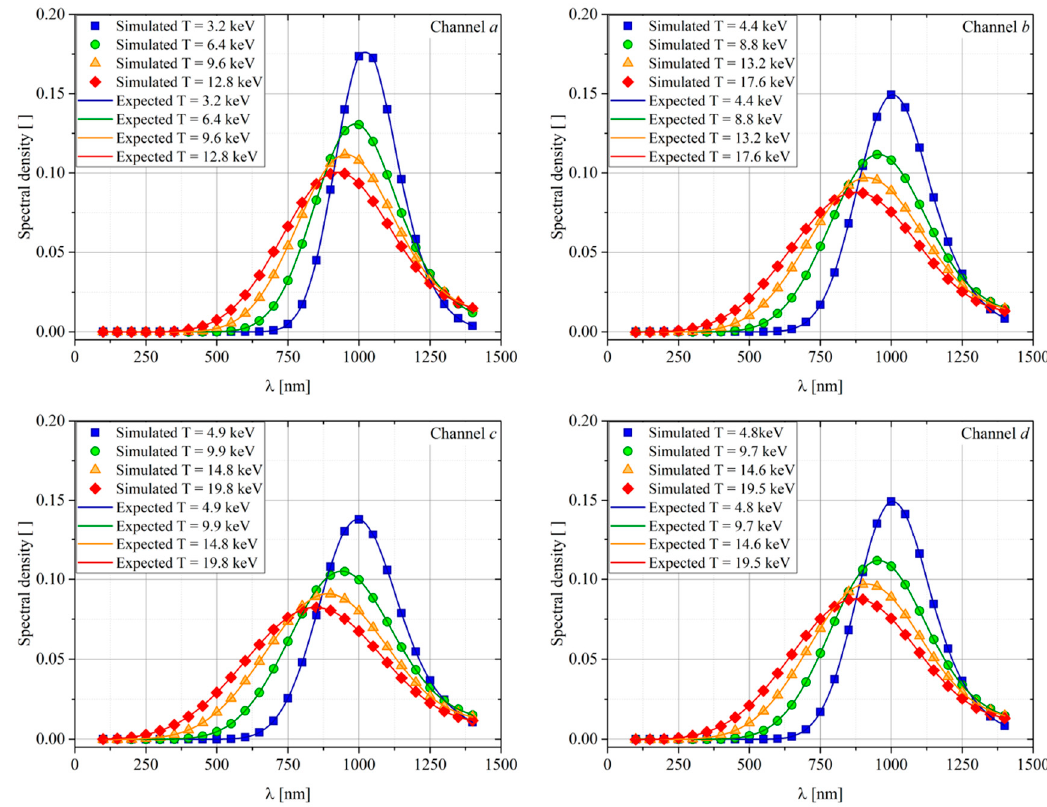
Figure 8. Thomson scattering expected and simulated adimensional spectra of the four channels as a function of the temperature.